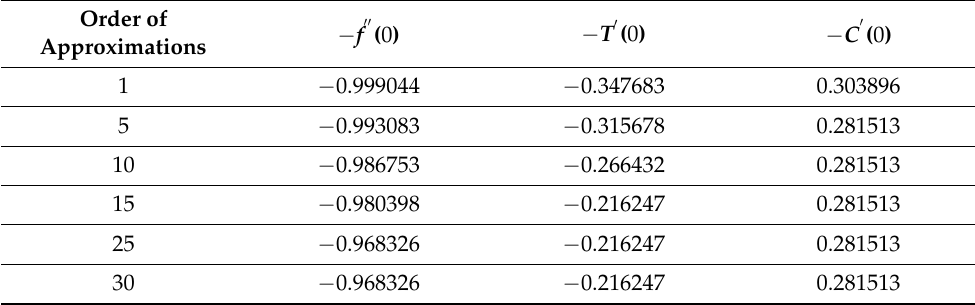
Table 1. Convergence analysis via distinct order approximations.